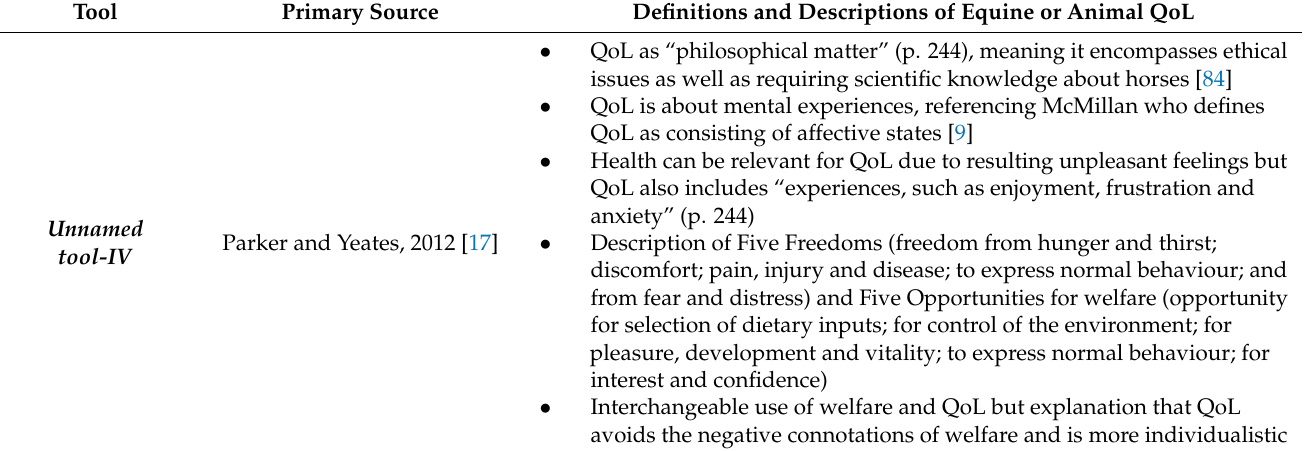
Table 3. Definitions and descriptions of equine or animal QoL in analysed publications of equine QoL assessment